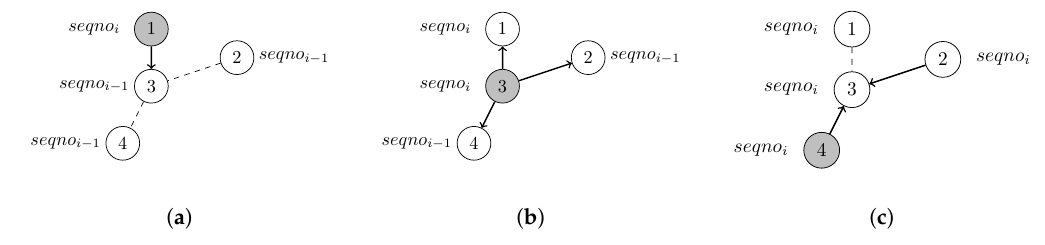
Figure 10. The Trickle protocol. The messages contain the nodes’ ID and sequence number seqno x . The current sender is colored in grey. The dashed lines indicate that two nodes are in transmission range of each other. The thick arrows indicate a transmission from one node to another one. ( a ) Node 1 broadcasts information with seqno i to node 3. ( b ) Node 3 updates its local stored information after receiving the information from node 1 and rebroadcasts the message with seqno i to node 1, 2, and 4. ( c ) Node 2 and 4 update their locally stored information after receiving the message from node 3 and broadcast the message with seqno i to node 3.